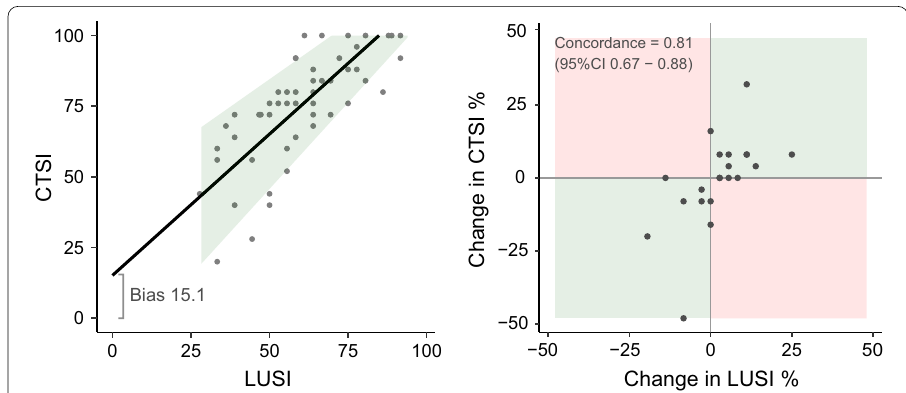
Fig. 2 a The correlation between LUSI and CTSI. Legend: the shaded area is a Bland–Altman where the line represents the biased association between the measurements (lung ultrasound underestimates CT involvement) and the shaded area represents the limits of agreement. The measurement error decreases with increased involvement. LUSI lung ultrasound score severity index; CTSI computed tomography severity involvement index. b Concordance between changes in sequentially measured LUSI and changes in CTSI. Legend: green squares denote concordance (involvement changes in the same direction) and red squares represent discordance (involvement changes in different directions). LUSI lung ultrasound score